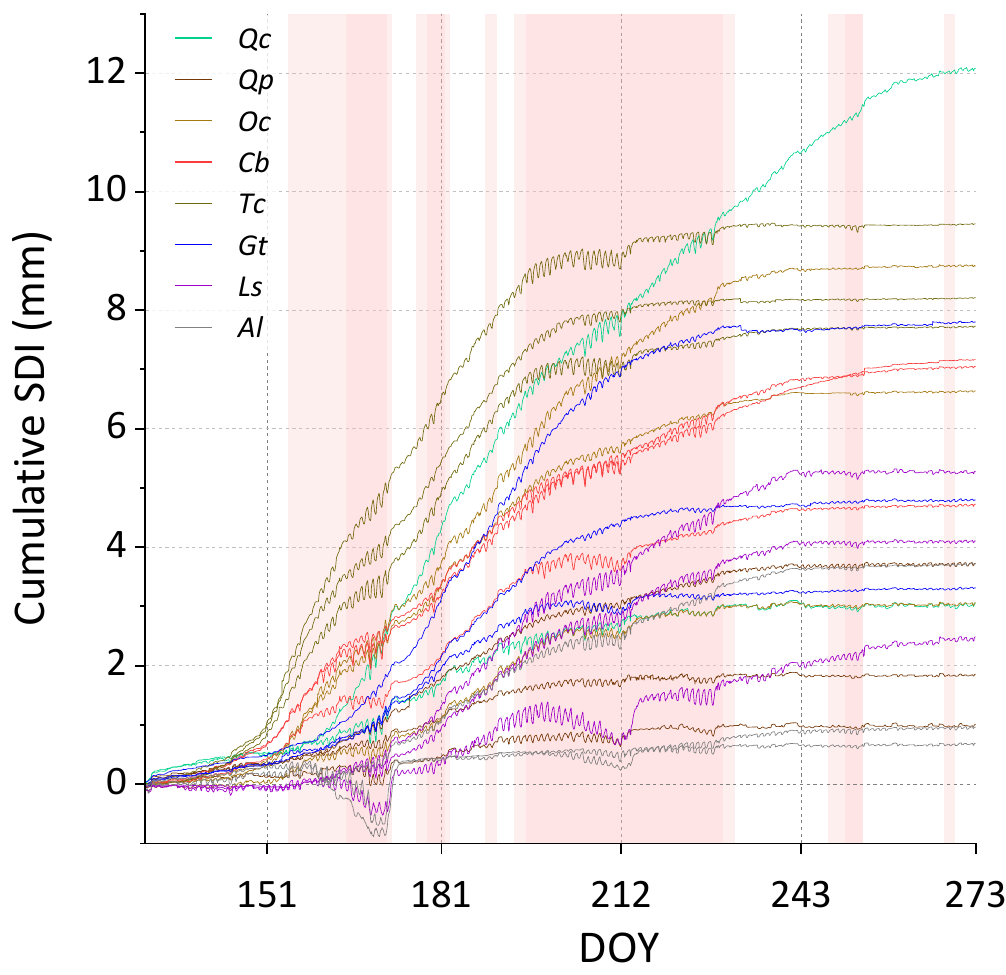
Figure 5. Cumulative stem diameter increment (SDI) of eight tree species grown in ‘Sand’ during the growing season of 2021. Reddish areas indicate phases when REW was <40% (light red: 0–35 cm; dark red: 0–100 cm).